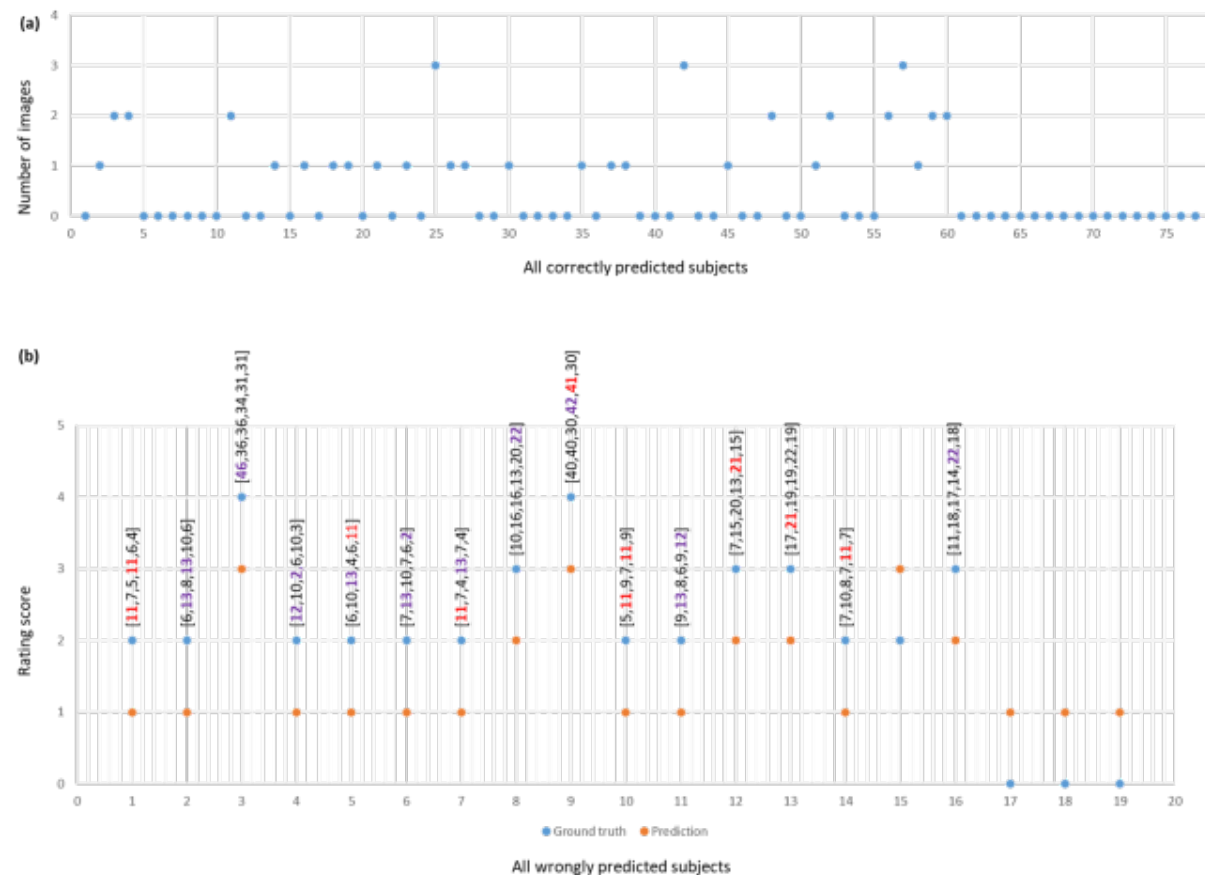
Figure 4. The prediction results of individual subjects: ( a ) All correctly predicted subjects (vertical axis; the number of images indicates the number of incorrectly predicted images per subject (out of six images per subject)). At subject level, all these subjects were rated correctly, although there were some incorrect predictions at image level. ( b ) All incorrectly predicted subjects (numbers corresponding to each subject in the brackets shows the number of EPVS found in each image). The numbers highlighted red and purple are the incorrect EPVS numbers identified in the corresponding image that have affected the final rating of the subject. We can also observe that the numbers highlighted in red are close to the decision boundary and caused under rating of EPVS when compared to ground truth.